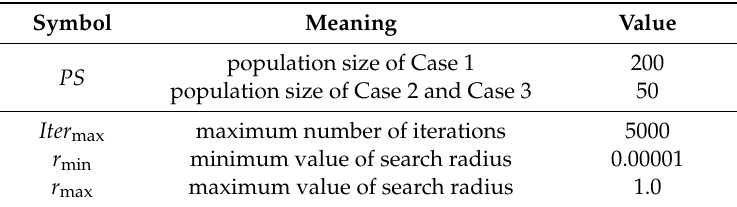
Table 4. Parameter setting values of